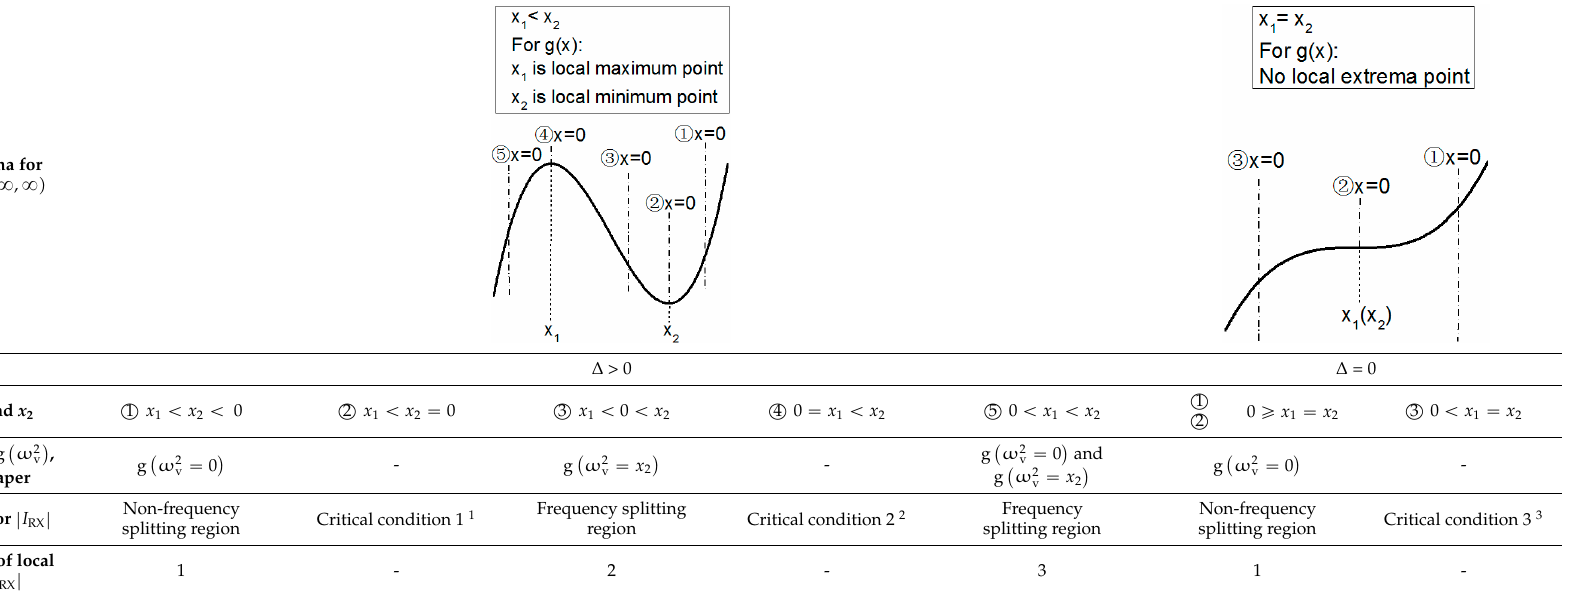
Table 2. Properties and graphs of g( x ) = x 3 + b p0 x 2 + c p0 x + d p0 for analyzing | I RX | (or power delivered to the load (PDL)).